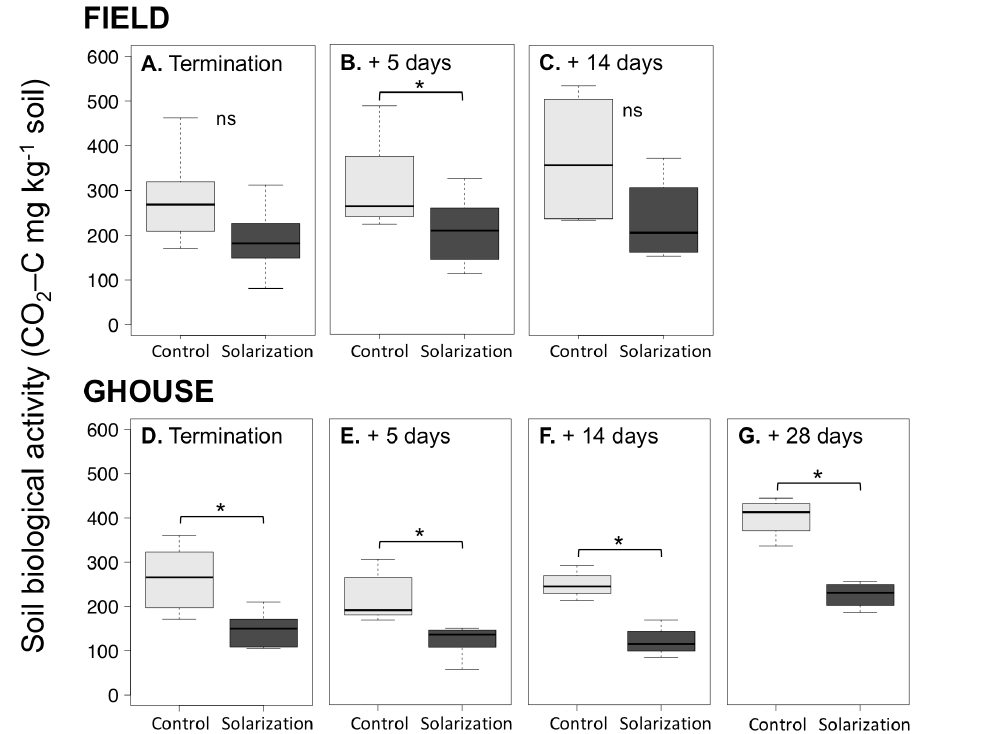
Figure 1. Soil biological activity in the FIELD experiment at (A) plastic termination, (B) termination + 5 days, and